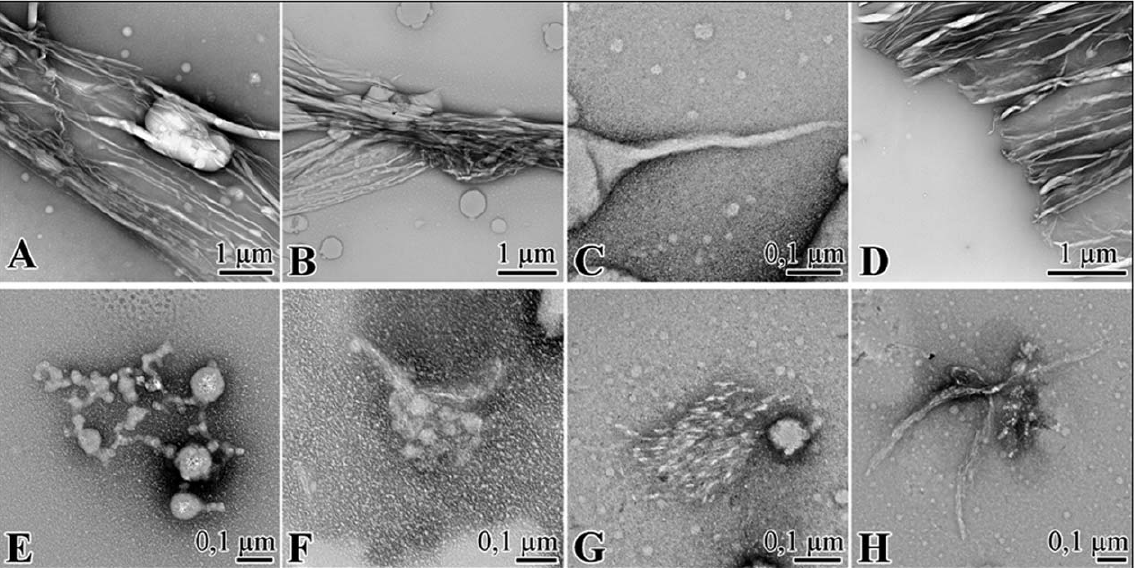
Figure 6. TEM images. Electron micrographs showing the a -ANP time course aggregation at pH 4.0 ( A,B,C,D ) and in 0.5 mM SDS at pH 7.4 ( E,F,G,H ).